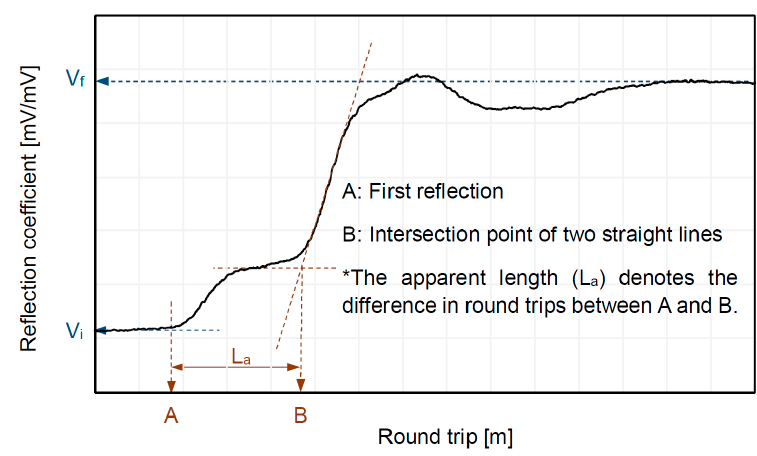
Figure 1. Example of a reflected waveform from TDR.